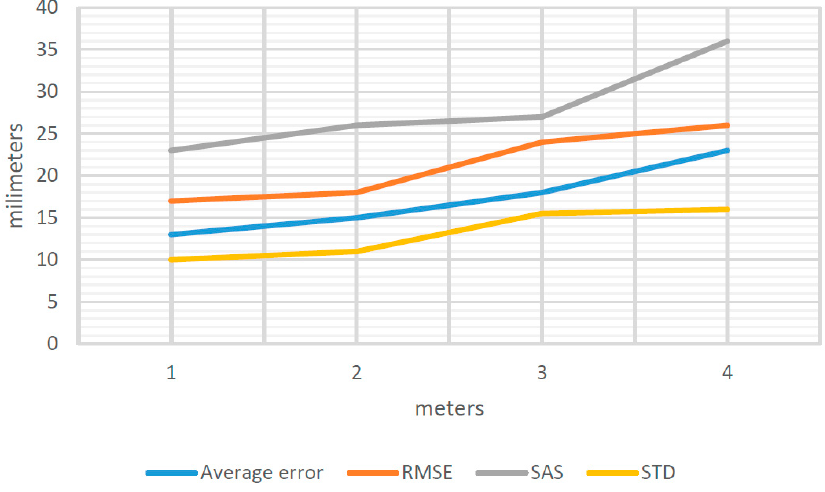
Figure 9. Average error, RMSE, SAS and STD for 1, 2, 3 and 4 m.